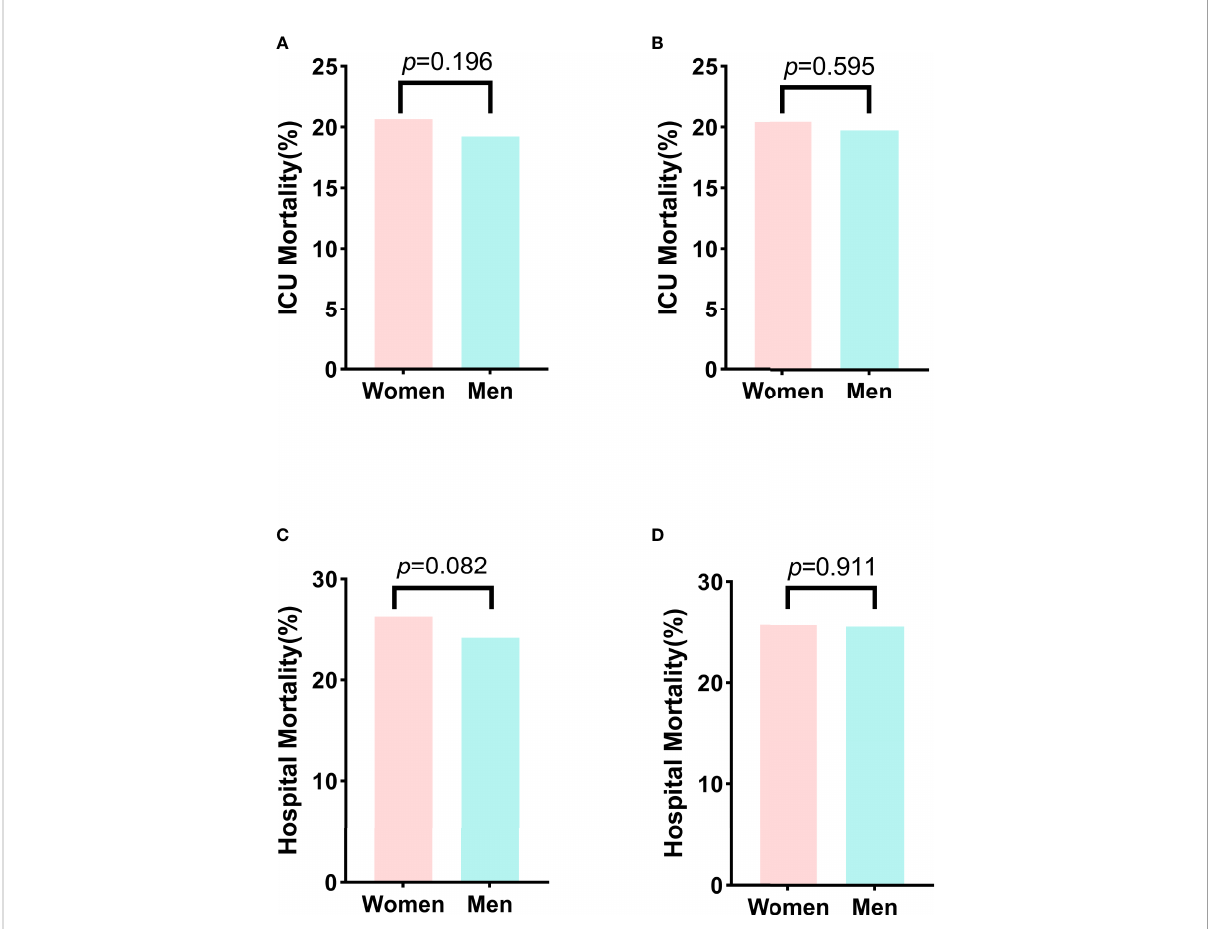
FIGURE 7 Comparison of the ICU and hospital mortality between men and women before matching and after matching. (A) The ICU mortality between men and women before matching. (B) The ICU mortality between men and women after matching. (C) The hospital mortality between men and women before matching. (D) The hospital mortality between men and women after matching. ICU, Intensive care